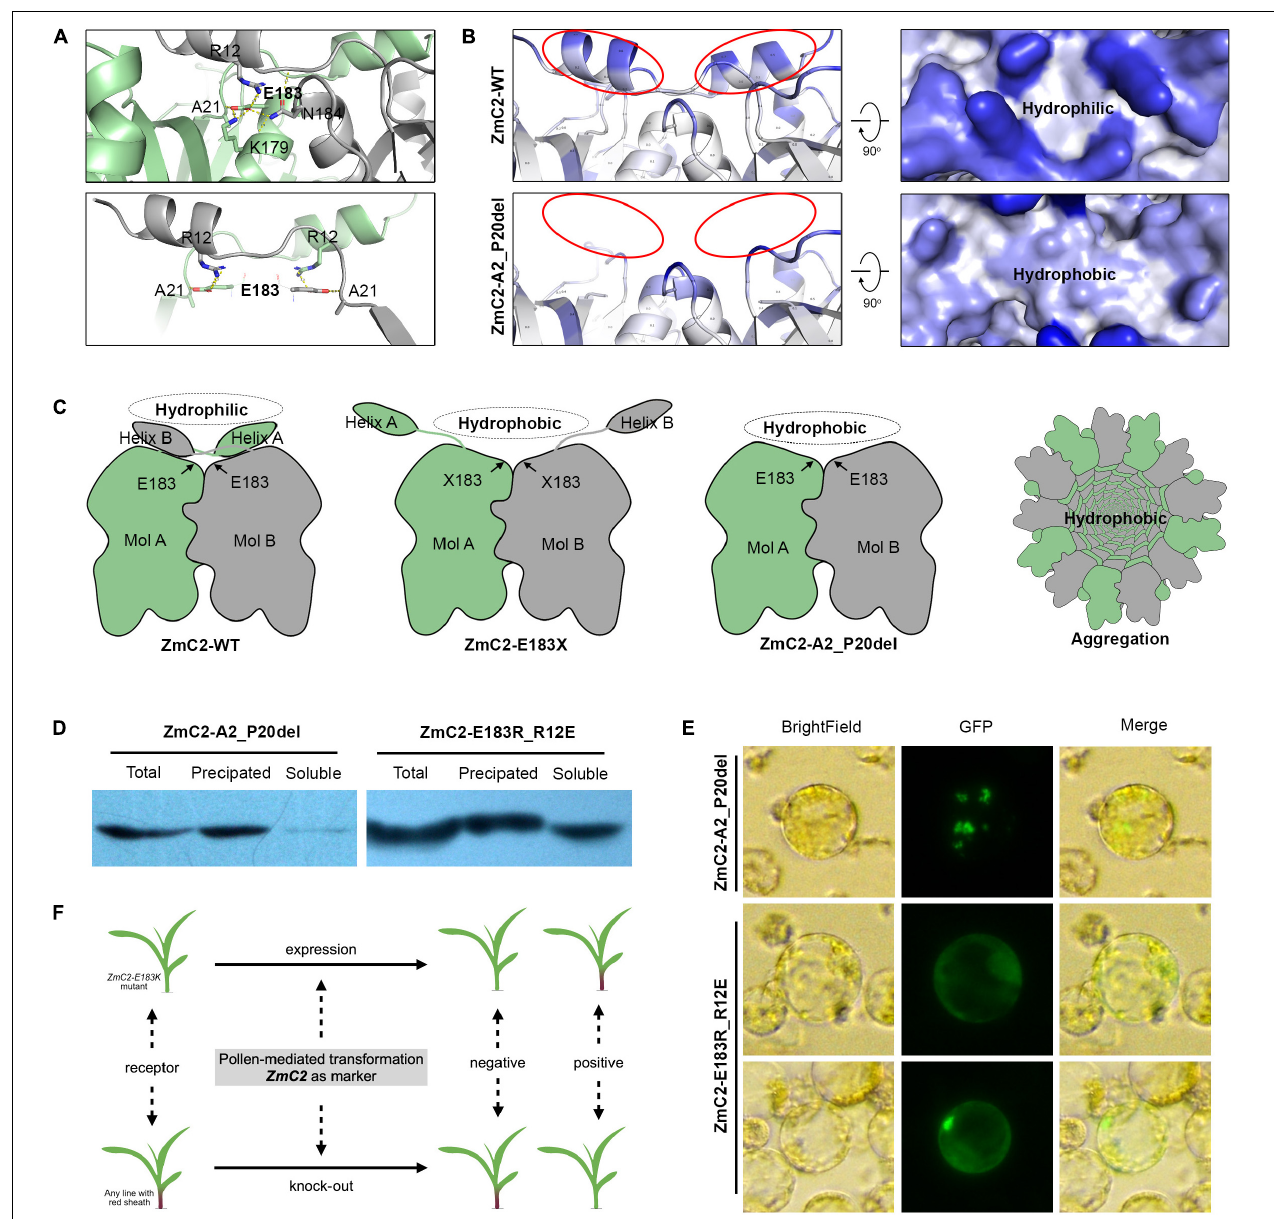
FIGURE 7 | Proposed aggregation model. ZmC2-WT represents the wild-type chalcone synthase ZmC2; ZmC2-E183K, ZmC2 with E to K missense mutation at 183rd amino acid; ZmC2-E183X, any missense mutation at E183; ZmC2-A2_P20del, deletion mutation from A2 to P20 (deletion of N-terminal helix); ZmC2-E183R_R12E, E183R and R12E double mutations. (A) Polar contacts analysis of E183 in ZmC2. The bottom panel highlights the contacts between E183 and N-terminal helix. (B) Solvent accessible analysis of ZmC2-WT and ZmC2-A2_P20del. (C) Simplified protein structure and aggregation model. (D) Western blot after prokaryotic expression for ZmC2-A2_P20del and ZmC2-E183R_R12E. Proteins were fused with 6xHis-tag at N-terminal. (E) Transient expression of ZmC2-A2_P20del and ZmC2-E183R_R12E. Proteins were fused with GFP-tag at C-terminal. (F) Potential usage of ZmC2 gene and ZmC2-E183K mutant line in maize